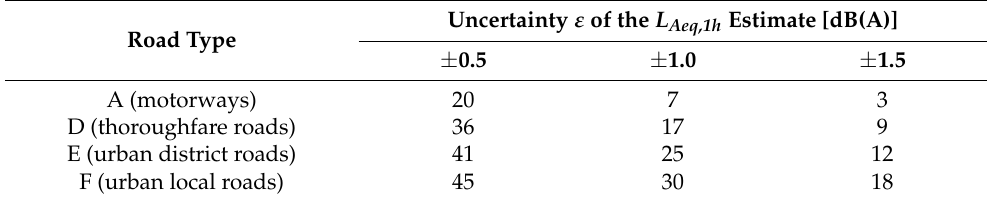
Figure 7. Estimate of 75th percentile of ST values for each type of road at each hour for uncertainty ε = ± 1.0 dB(A). Table 4. Mean values in the day period 7–19 h of 75th percentile of ST values 1 estimated by Equation (5) for each road type and uncertainty ε .